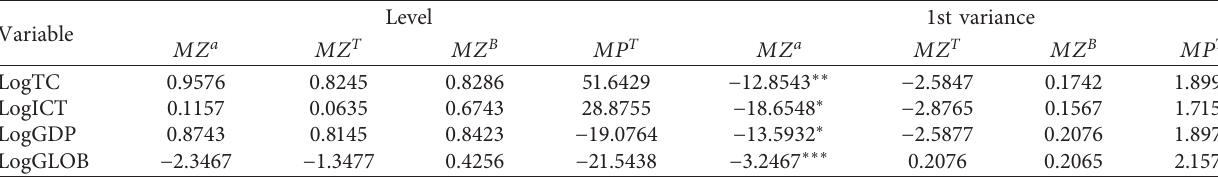
Table 1: NG-Perron unit root test.